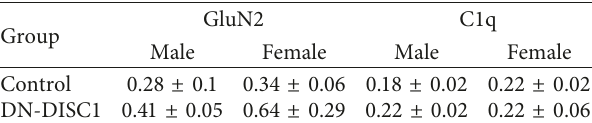
Table 2: Absence of group- or infection-related effects on anti- GluN or anti-Anti-C1q